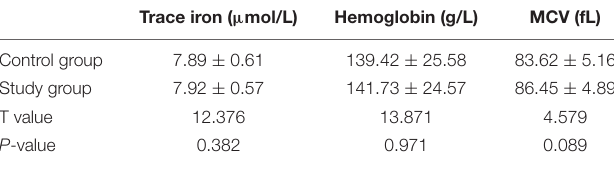
TABLE 4 | Comparison of the test results of the trace iron, hemoglobin content, and red blood cell volume between the study and control groups [ x ± s, n = 60]. Trace iron ( µ